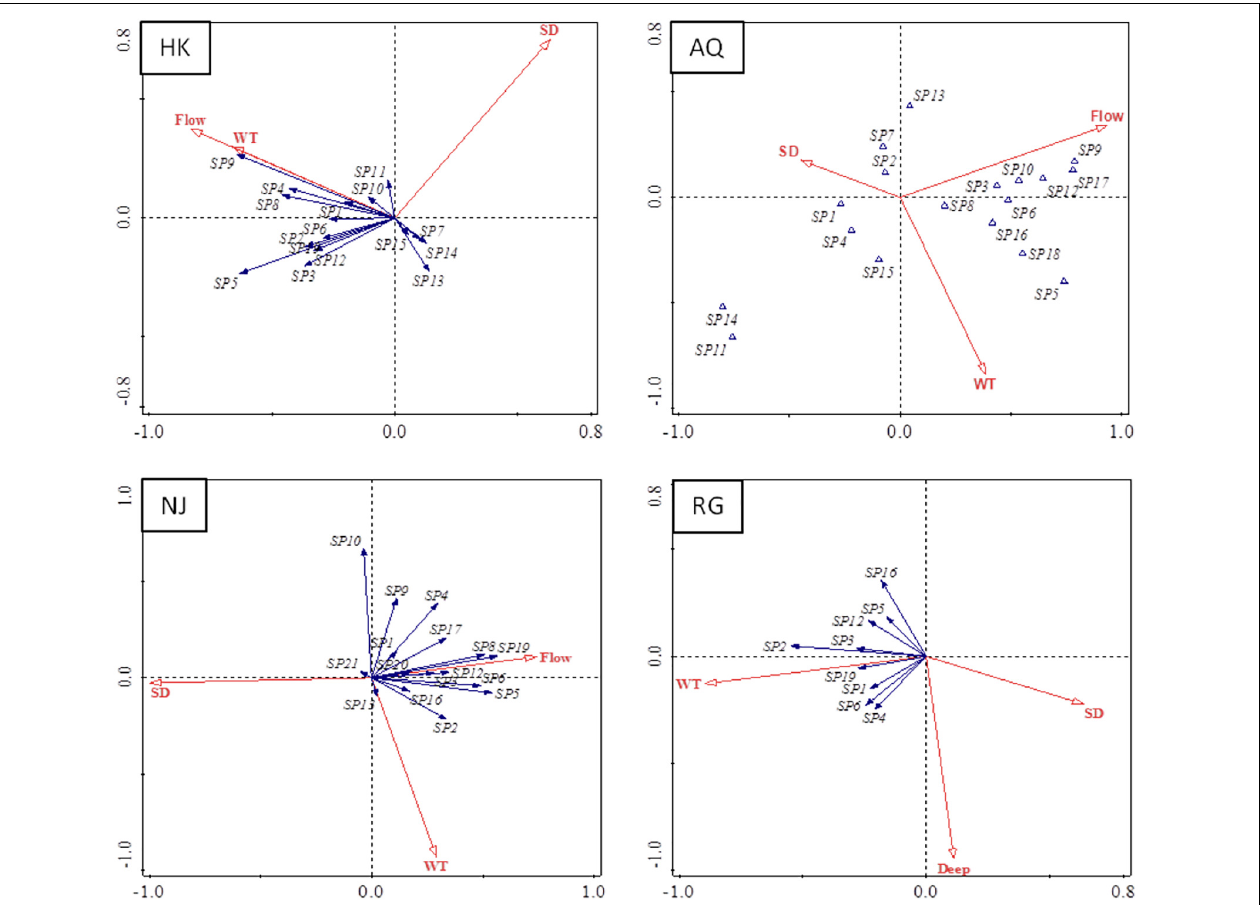
FIGURE 4 | Distance-based redundancy analysis (db-RDA) analyses for ichthyoplankton species and environmental variables. The blue solid arrow represents the larval fish species; the red hollow arrow represents environmental variables. The quadrant of the red arrow represents the positive or negative correlation between environmental factors and the sorting axis. The length of the red arrows represents the degree of correlation between an environmental factor and community distribution. The angle between the red arrow line and the sorting axis represents the correlation between an environmental factor and the sorting axis, the smaller the angle, the higher the correlation. The spn presents different larval fish species as follows: sp1, Hemiculter bleekeri ; sp2, Hemiculter leucisculus ; sp3, Rhinogobius giurinus ; sp4, Xenocypris argentea ; sp5, Coilia nasus ; sp6, Pseudolaubuca sinensis ; sp7, Saurogobio dabryi ; sp8, Parabramis pekinensis ; sp9, Culter dabryi , sp10, Xenocypris davidi ; sp11, Hyporhamphus intermedius ; sp12, Culter alburnus ; sp13, Neosalanx tangkahkeii ; sp14, Squalidus argentatus ; sp15, Pseudobrama simony ; sp16, Pseudolaubuca engraulis ; sp17, Xenocypris microlepis ; sp18, Hypophthalmichthys molitrix ; sp19, Siniperca chuatsi ; sp20, Carassius auratus ; and sp21, Hypophthalmichthys nobilis